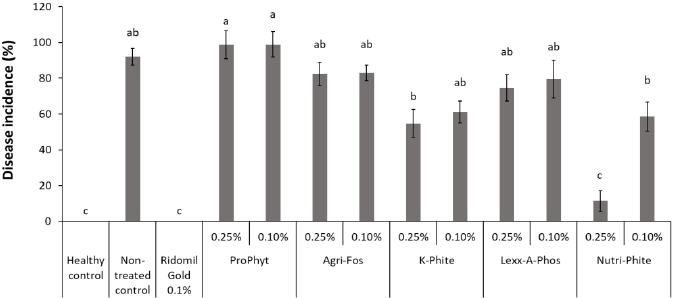
Figure 1. Phytophthora blight incidence on bell pepper cv. Camelot under different treatments. Data are the mean of four replicates ± standard deviation. Values capped by the same letters are not significantly different according to Fisher’s least significant difference test ( p = 0.05).